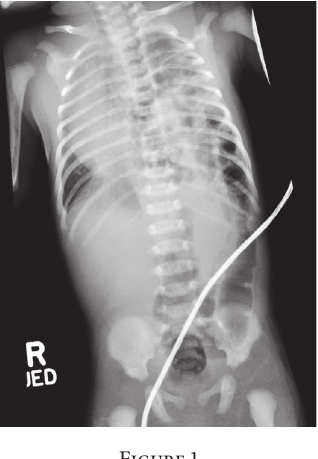
cells, 33 lymphocytes, and 11 monocytes. A chest X-ray was obtained and demonstrated a left-sided congenital diaphrag- matic hernia (Figure